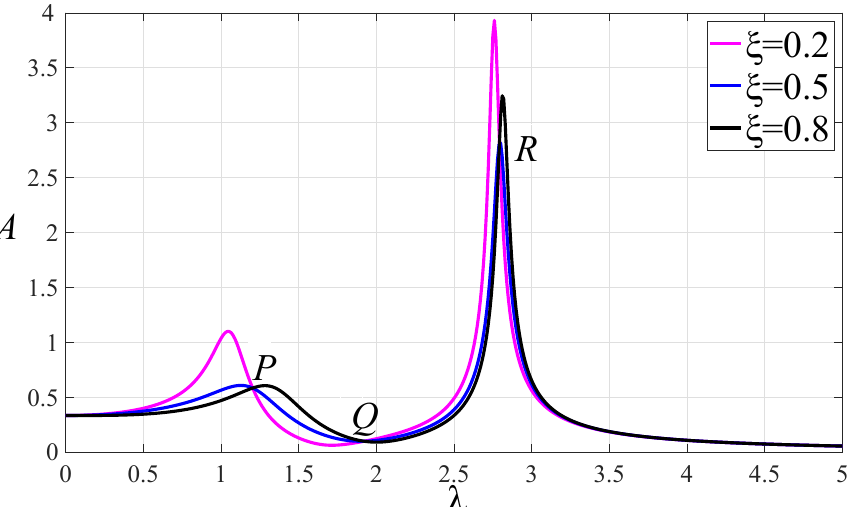
Figure 2. The normalized amplitude–frequency curves of system with µ = 0.1, β = 1.5, ν = 2, α 1 = 1, α 2 = 0.7, L =